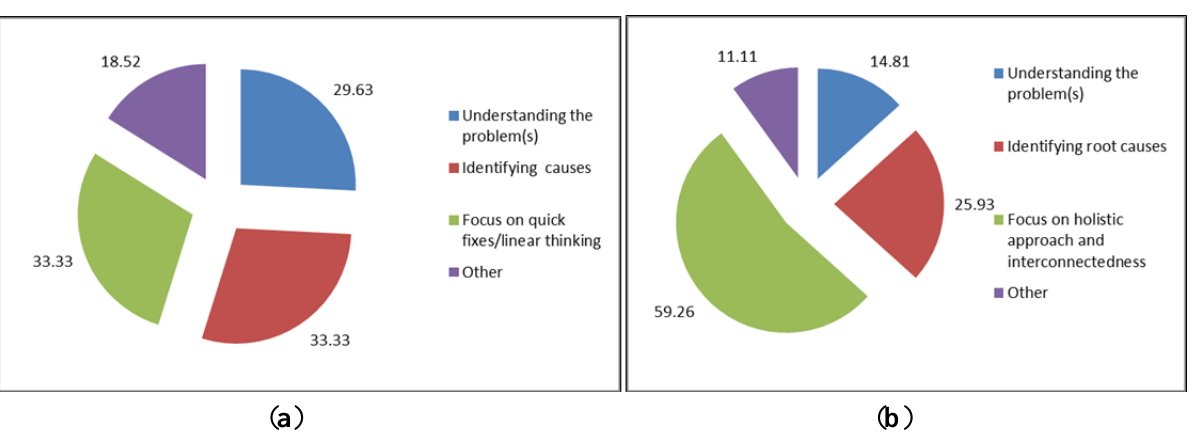
Figure 8. Comparison of the students’ way of thinking and approaches to problem solving before and after being involved in the Ecopolicy program. Source: [101]. ( a ) Pre-involvement in Ecopolicy; ( b ) after involvement in